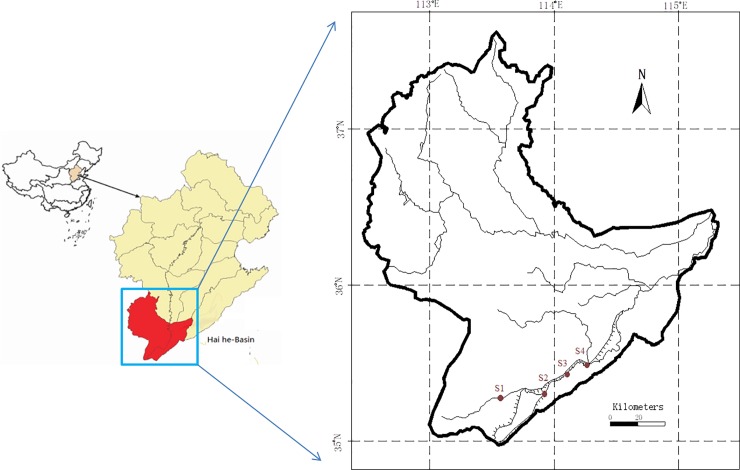
Sample stations (S1-S4) in the Weihe-river and its geographical location.